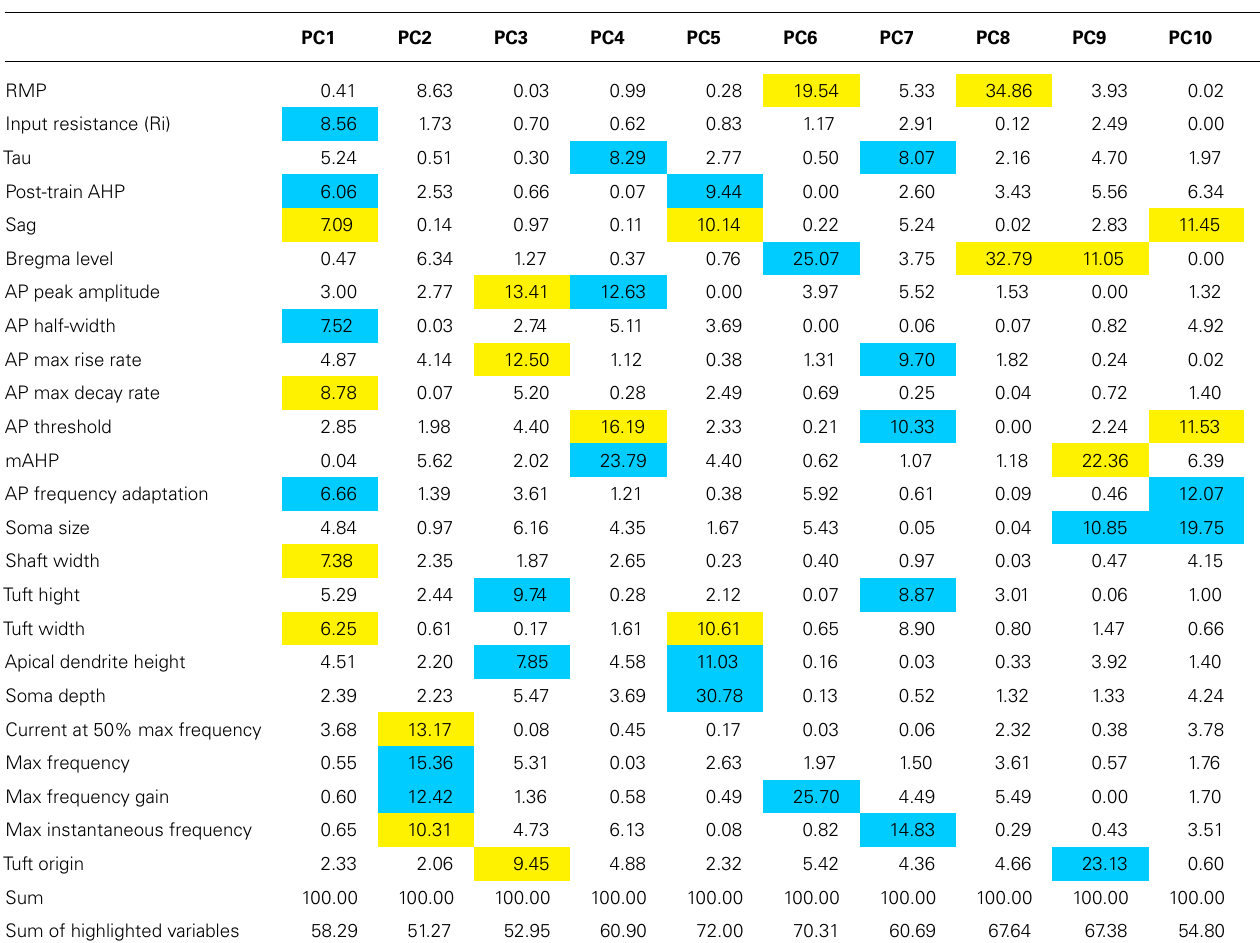
Table 4 | Squared coefficients expressed as percentages for the first 10 principal